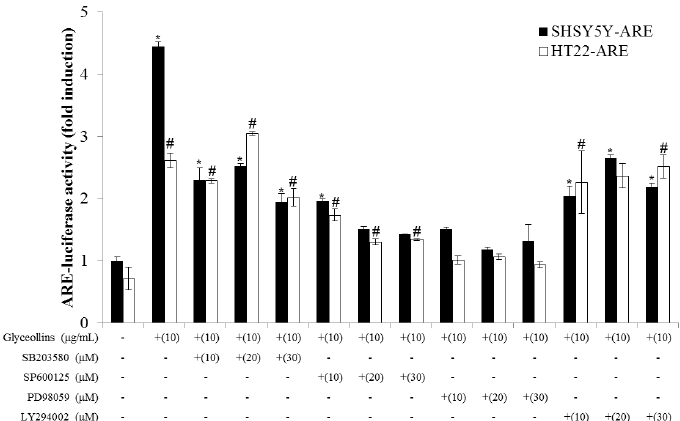
Figure 5. Effect of inhibitors of MAPK, PI3K on Nrf2 transcriptional activation by glyceollins, as evaluated by reporter assay. SHSY5Y-ARE or HT22-ARE cell lines were treated with glyceollins in the presence or absence of inhibitors for MAPK and PI3K for 16 h followed by measuring luciferase activity. Bars represent mean ± SD ( n = 4). *, Significantly different from the untreated control ( p < 0.05) in SHSY5Y-ARE cells. #, Significantly different from the untreated control ( p < 0.05) in HT22-ARE cells.